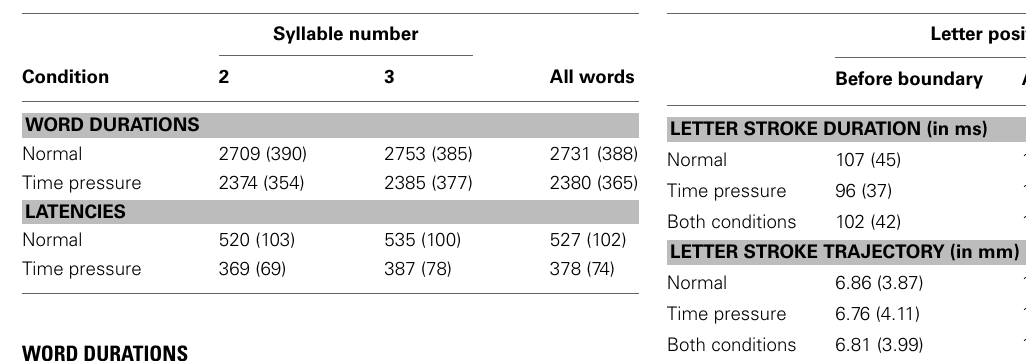
Table 2 | Single-letter measures (means and standard deviations) as a function of writing condition and letter position in relation to the first syllable boundary.